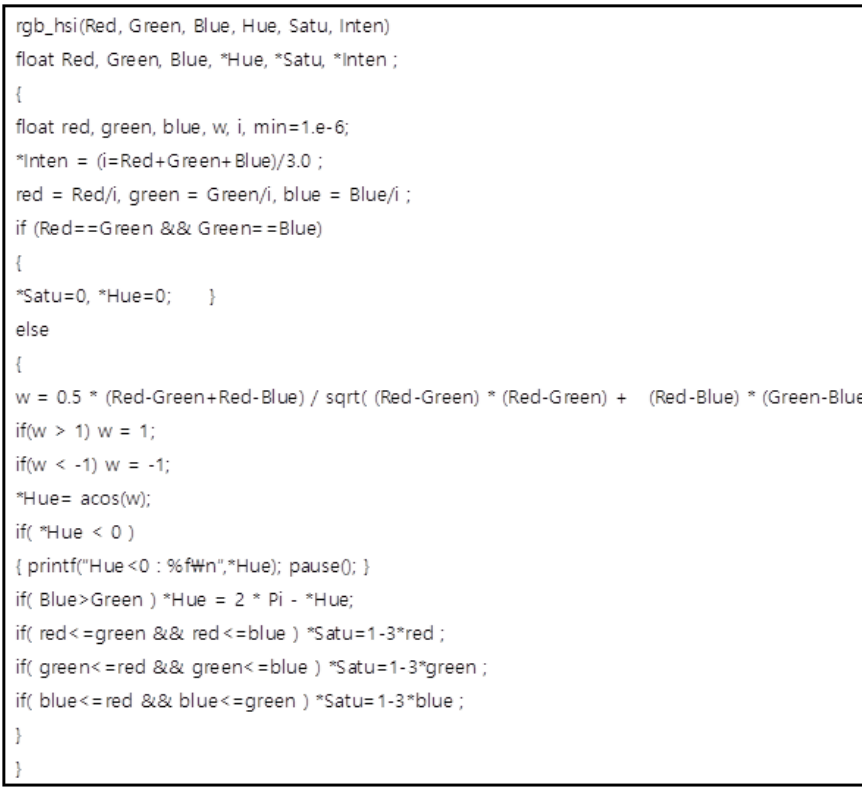
Figure 6. RGB to HSI conversion